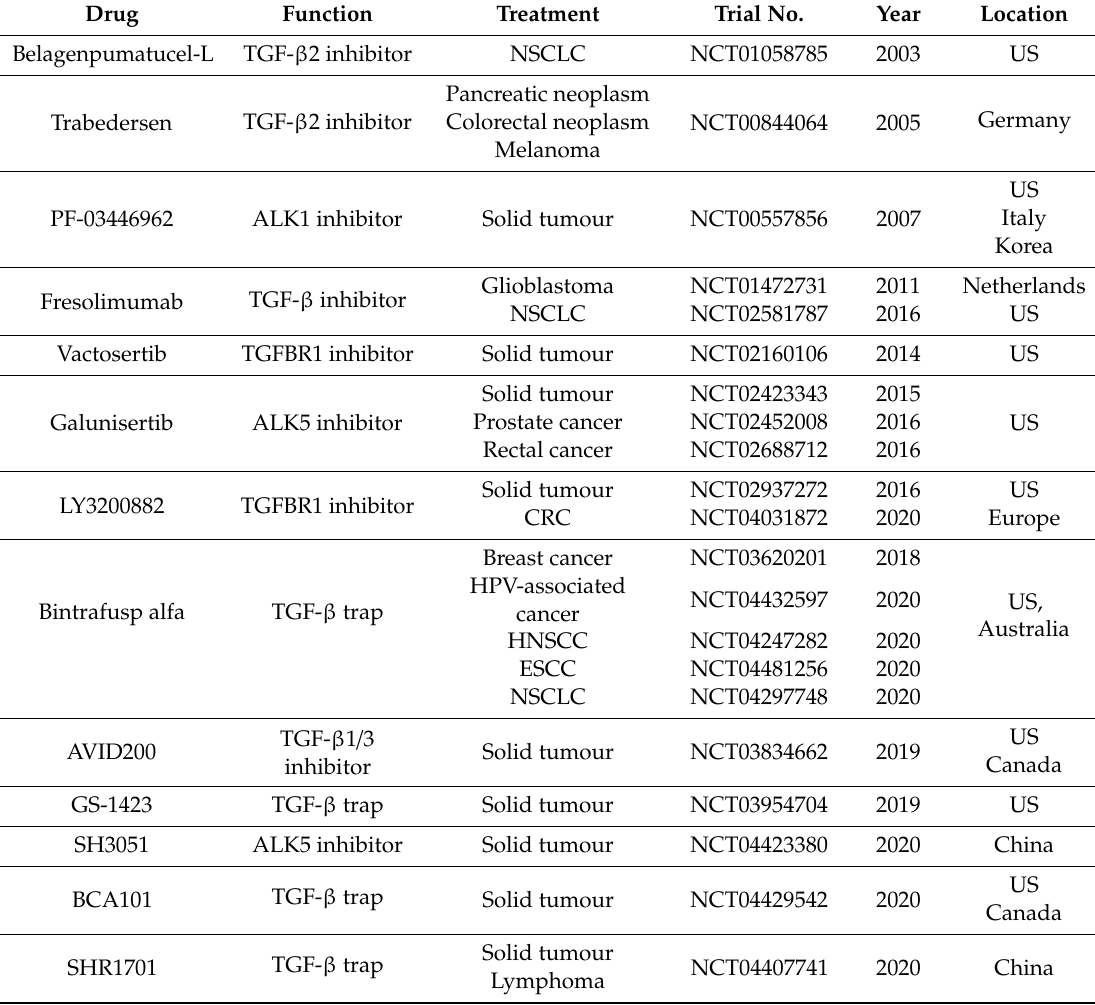
Table 3. Clinical trials of the TGF- β pathway inhibitors for cancer